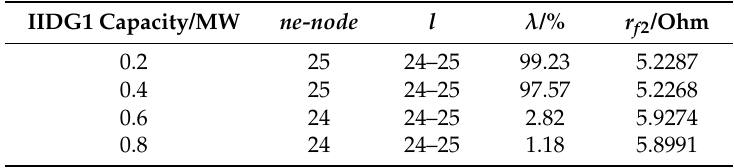
Table 15. Locating results of Strategy 2 with different capacities of IIDG1 for Case 5.